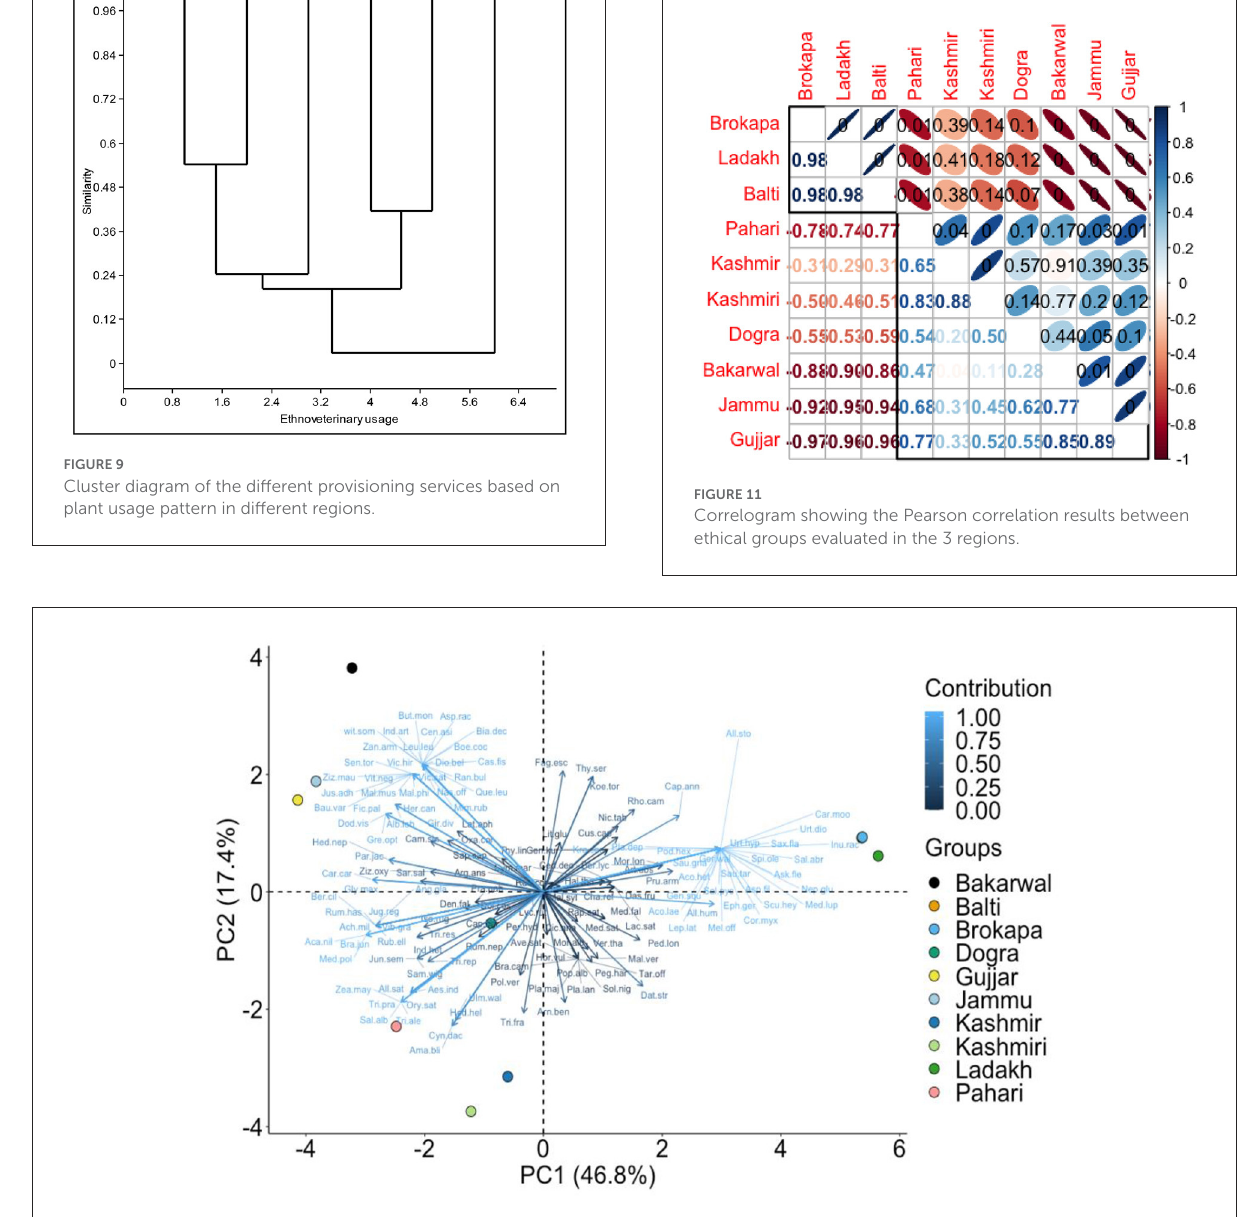
FIGURE10 PCA diagram representing clustering of plant species among 3 regions and ethical groups. The complete name of species is show in Supplementary Table 1.